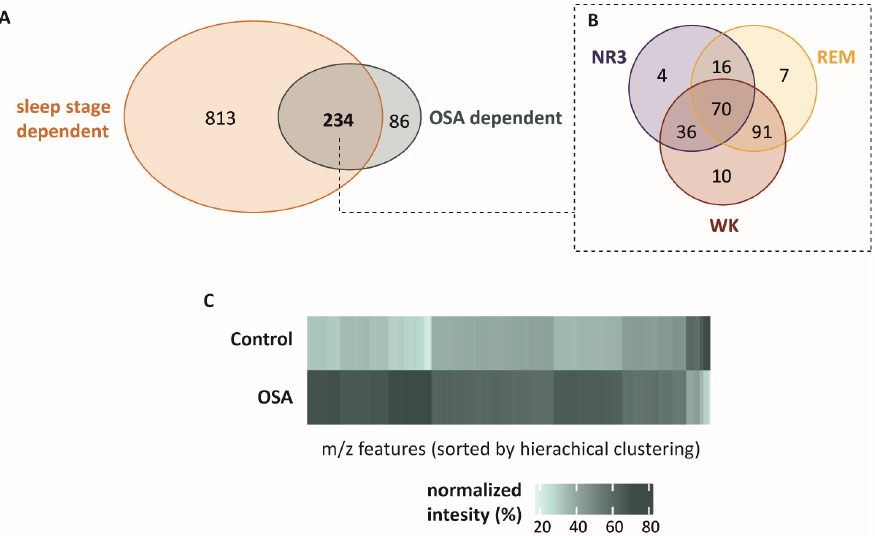
Figure 2. ( A ) Venn-diagram showing 1133 breath features that are either sleep-stage- or OSA-dependent. ( B ) A total of 234 sleep-stage-dependent features were also dysregulated in OSA patients compared to controls ( p ≤ 0.05). Furthermore, these overlapping breath features are associated with different sleep phases (NR3 = non-rapid-eye-movement sleep—stage 3; REM = rapid-eye-movement sleep; WK = wakefulness). ( C ) The heat map shows the differences between the medium intensity of breath features in the symptomatic OSA group and the control group for these 234 m/z features. OSA patients show higher intensities (dark green) in most of the breath features. The intensities are represented as % of the sum of both groups.